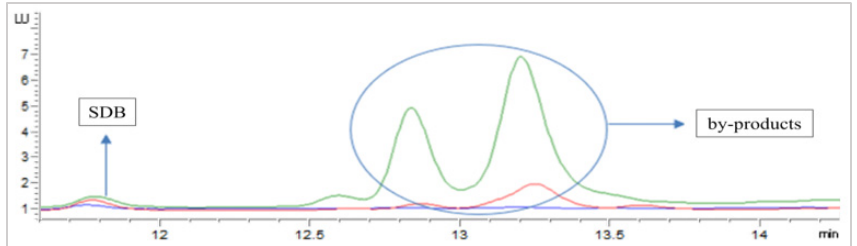
Figure 2. HPLC-FLD chromatograms of 12.5 µM Na 2 S solution derivatized with 10 mM (green), 1.5 mM (red) and 0.15 mM (blue) MBB.